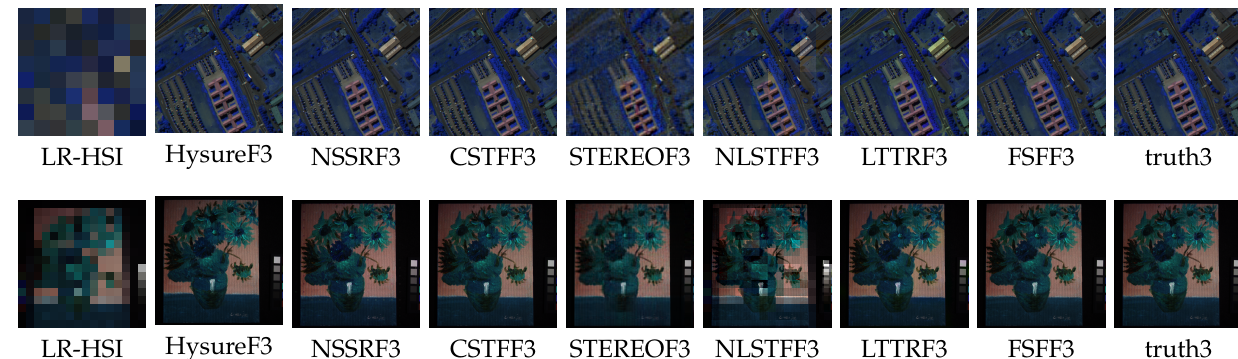
Figure 3. First row: LR-HSI, fusion images, and ground truth images’ false-color images (formed by bands 30th, 60th, and 90th) in Pavia university. Second row: LR-HSI, fusion images, and ground truth images’ false-color images (formed by bands 10th, 19th, and 28th) of oil_painting in the CAVE database.